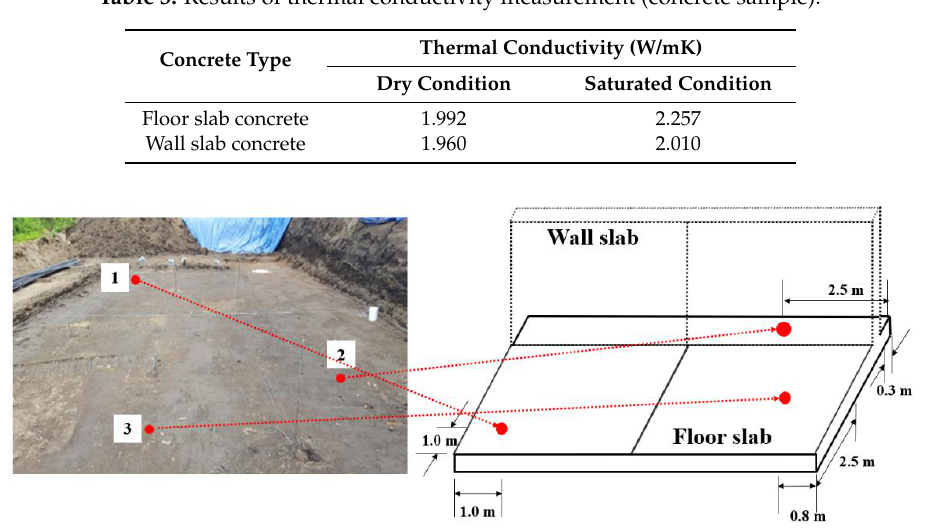
Figure 4. Measurement points for the thermal conductivity of the ground.